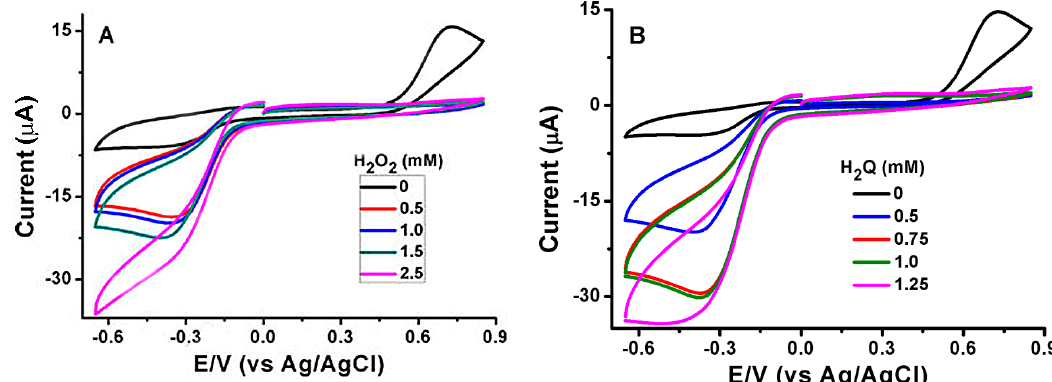
Figure 2. Cyclic voltammograms recorded at 50 mV s − 1 with deoxygenated 0.05 M PBS (pH 7.4) containing ( A ) 1 mM H 2 Q and 0.0, 0.5, 1.0, 1.5, 2.5 mM H 2 O 2 ; or ( B ) 1.5 mM H 2 O 2 and 1.0, 1.5, 1.75, 2.0, 2.25 mM H 2 Q.